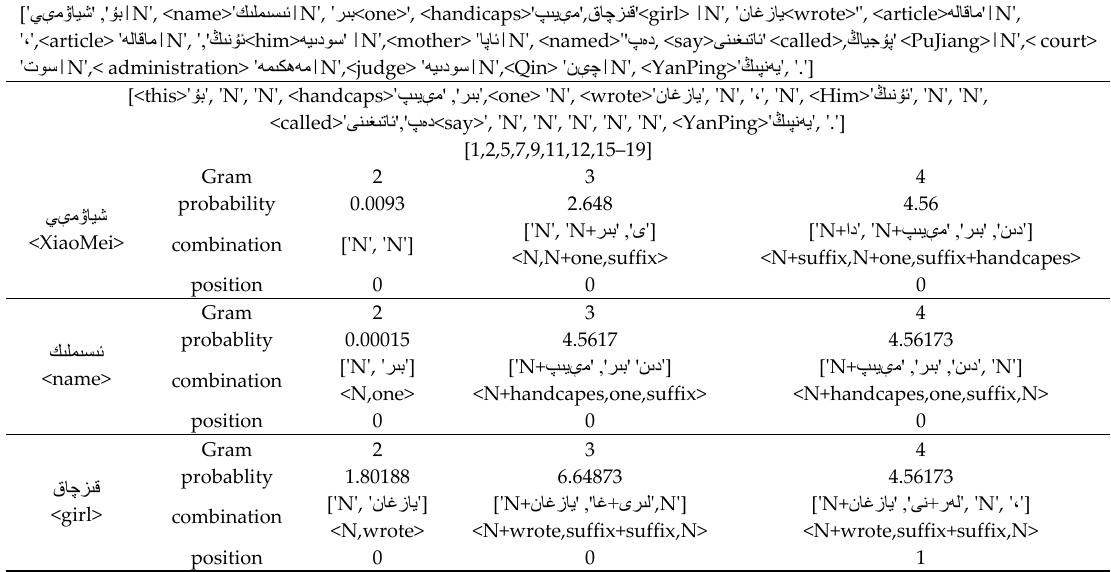
Table 3. Part of the information about combination details.